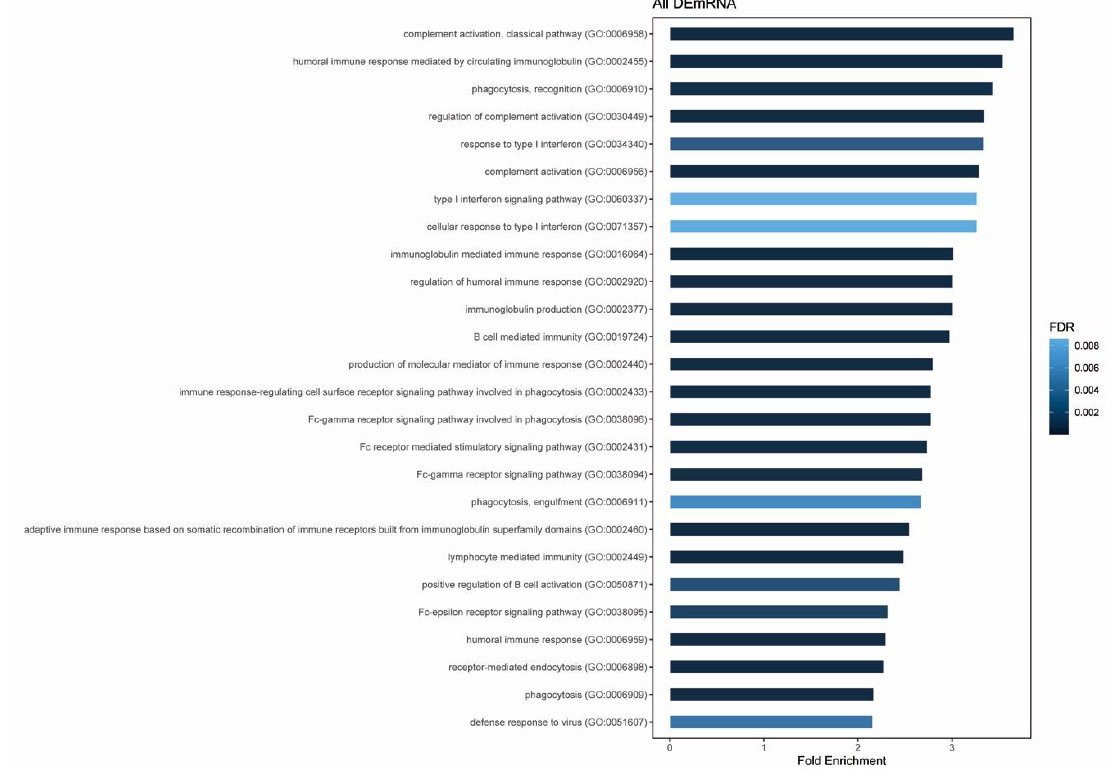
Figure 4. Results from gene overrepresentation test of 2441 DEmRNA. The most significant (fold-enrichment > 2) and enriched (FDR < 0.01) GO biological processes are shown. Bars are colored according to their FDR value. DE—differentially expressed. FDR—false discovery rate.